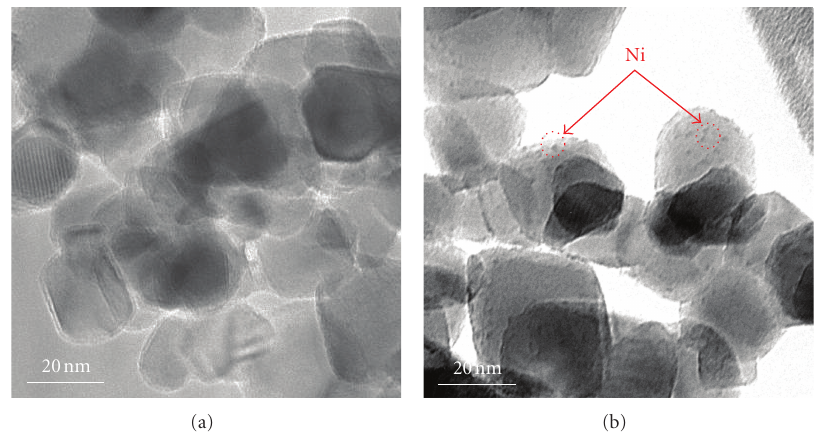
Figure 5: TEM morphology of (a) P25 and (b) 1% Ni-TiO 2 .